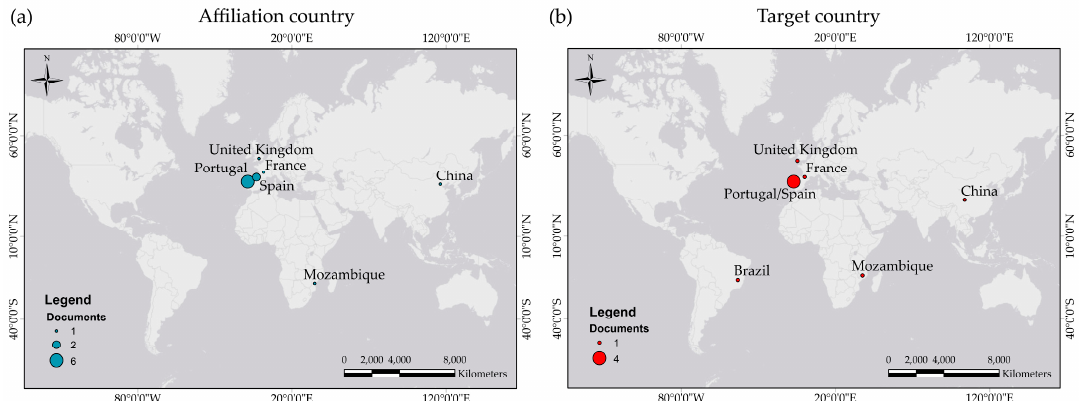
Figure 3. ( a ) Geographic distribution of the retrieved publications taking into account the affiliation country. ( b ) Geographic distribution of the analyzed publications considering the study area of the work. In some cases, the study area encompasses more than one country (Portugal/Spain).